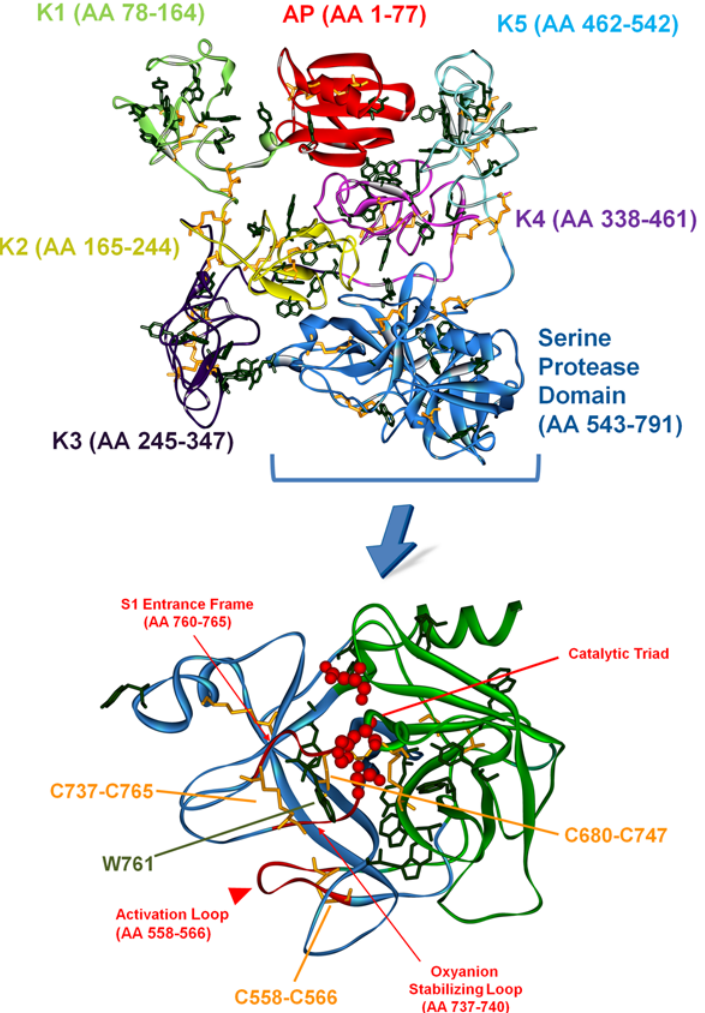
Fig 1. Tertiary structure of native human plasminogen. Top panel: Full length native 3D structure of native human Glu1-Pmg. The activation peptide (AP), the 5 kringle domains (K1 to K5), and the serine protease domain (where the catalytic site is located) are highlighted with different colors. The 24 disulphide bonds are displayed in orange in stick configuration, and the Trp and Tyr residues are displayed in dark green in stick configuration. Bottom panel: detailed 3D structure of the serine protease domain of human Glu1-Pmg (Ala543-Asn791). The C and N subdomains of plasminogen are displayed in blue and green, respectively. The disulphide bonds are displayed in stick configuration (orange) and two important disulphide bonds are highlighted: Cys556-Cys566 and Cys737-Cys765. The Trp and Tyr residues in the Serine Protease domain are displayed in line configuration (dark green). The active site residues (catalytic triad His603, Asp646 and Ser741 for plasminogen) are displayed as red CPK (0.5 Å radius). The three important loops involved in plasminogen activation are displayed in red: the oxyanion stabilizing loop, the S1 entrance frame and the activation loop. The xyz atomic coordinates for 3D representation were extracted from the crystallized structures of Glu1-Pmg (4A5T.pdb)